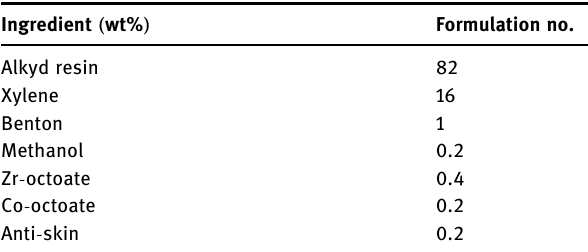
Table 2: Formulation of modi fi ed alkyd vehecle based on HECA as new